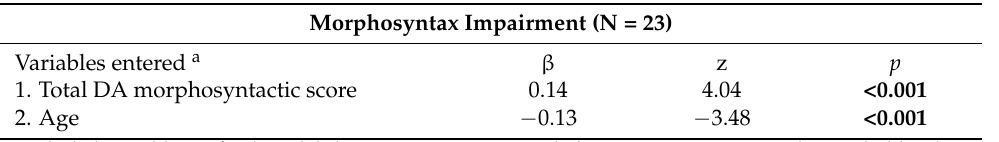
Table 8. Stepwise logistic regression: classification of morphosyntactic impairment (dependent variable), using total DA morphosyntactic score and age as independent variables.